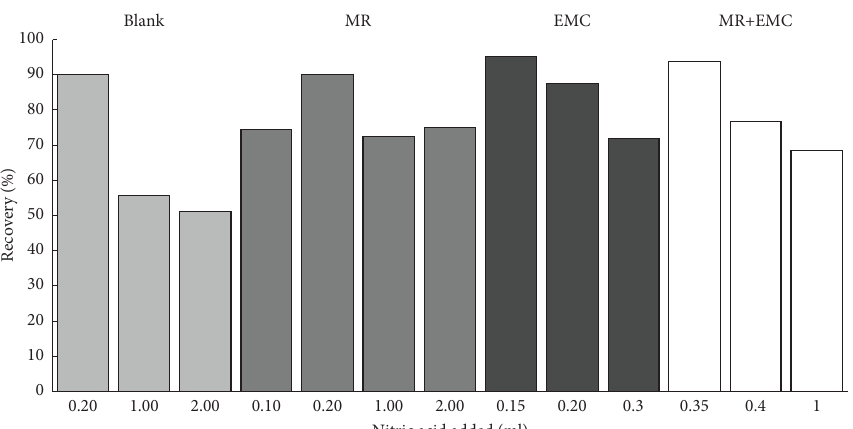
Figure 5: Perchlorate recovery values obtained showing dependence on the volume of nitric acid added. Te total volume added was constant at 3.0 mL. For example, if 0.2 mL of concentrated nitric acid ( ∼ 15.9)M was added, 2.8mL of water was also added.